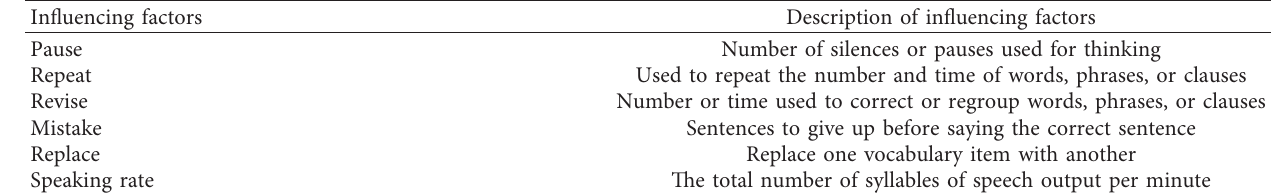
Table 1: Factors affecting oral English